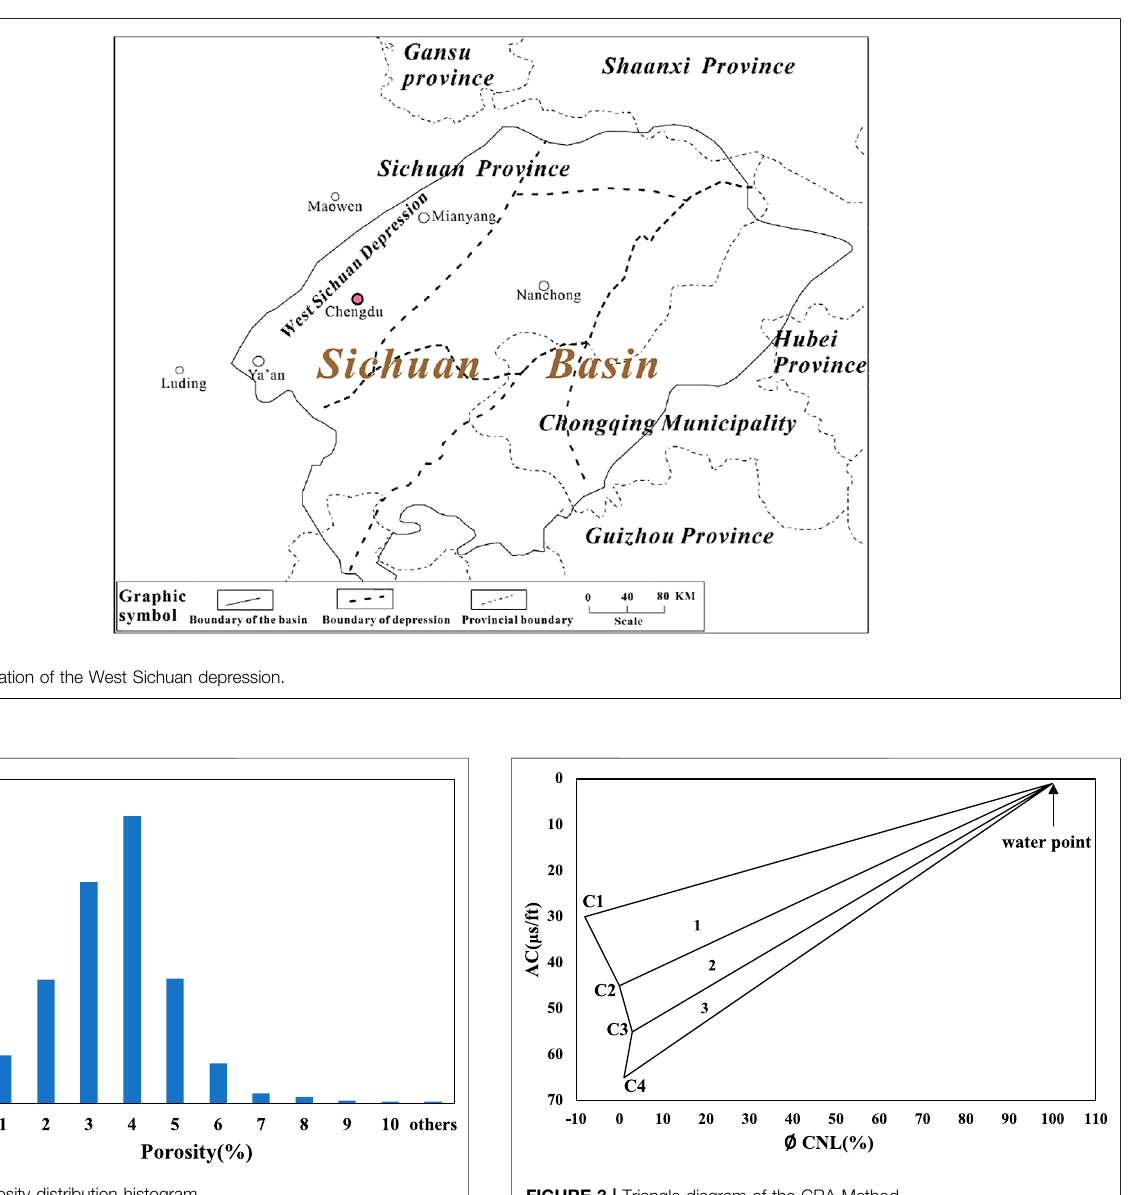
FIGURE 2 | Porosity distribution histogram. FIGURE 3 | Triangle diagram of the CRA